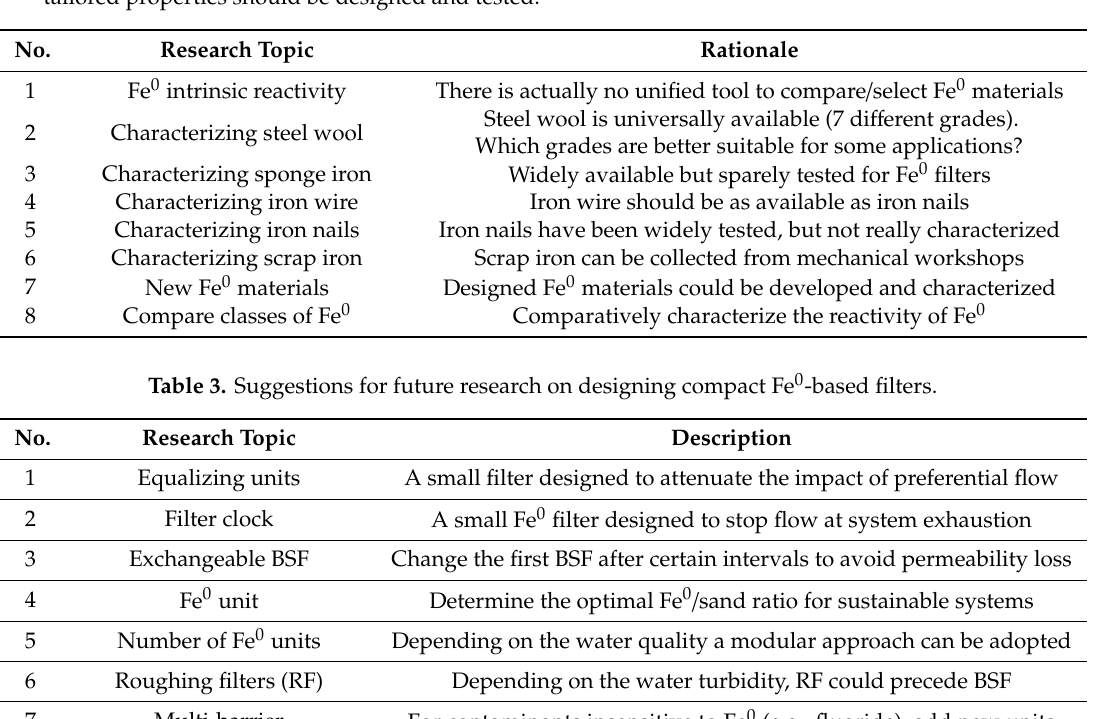
Table 2. Suggestions for future research on suitable Fe 0 materials for filters. The goal is to characterize the suitability of available Fe 0 materials for individual site-specific applications. New materials with tailored properties should be designed and tested.